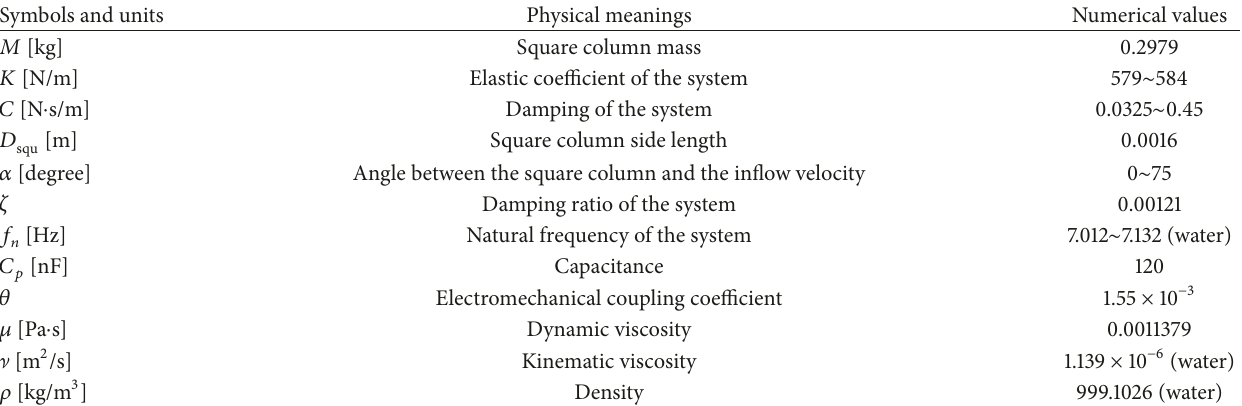
Table 1: Calculation parameters for square column VIVPEH